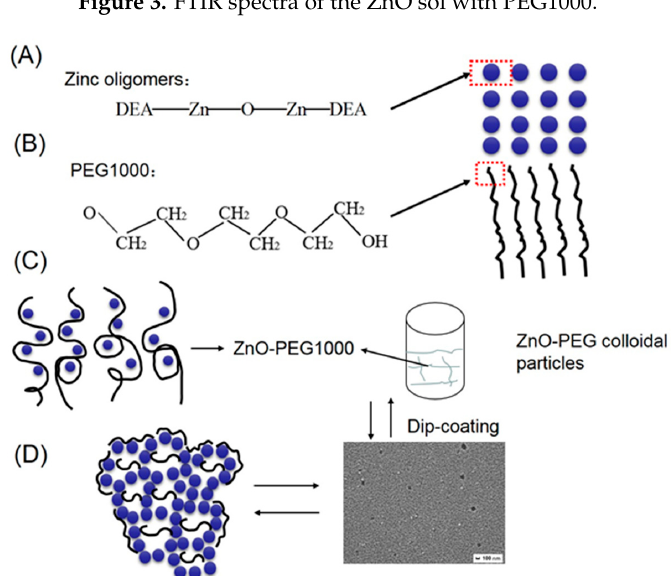
Figure 4. ( A ) Schematic representation of the zinc sols, ( B ) PEG1000, ( C ) PEG1000 connected with sol particles, and ( D ) porous ZnO thin films.